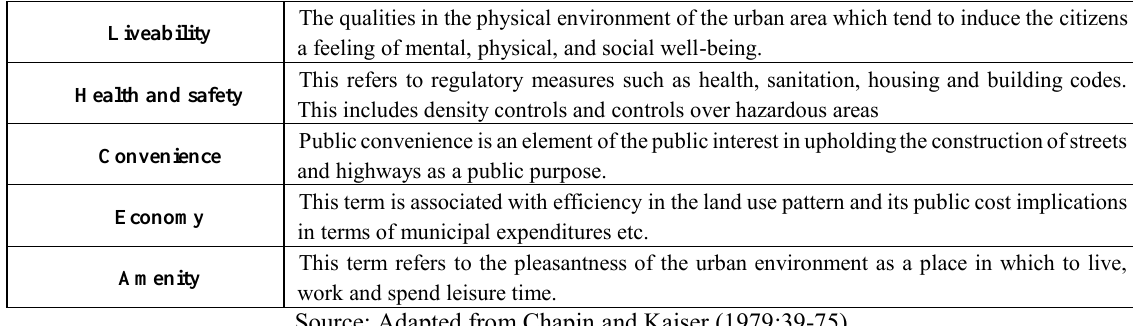
Table 4: Chapin and Kaiser’s spatial planning principles for the best practice